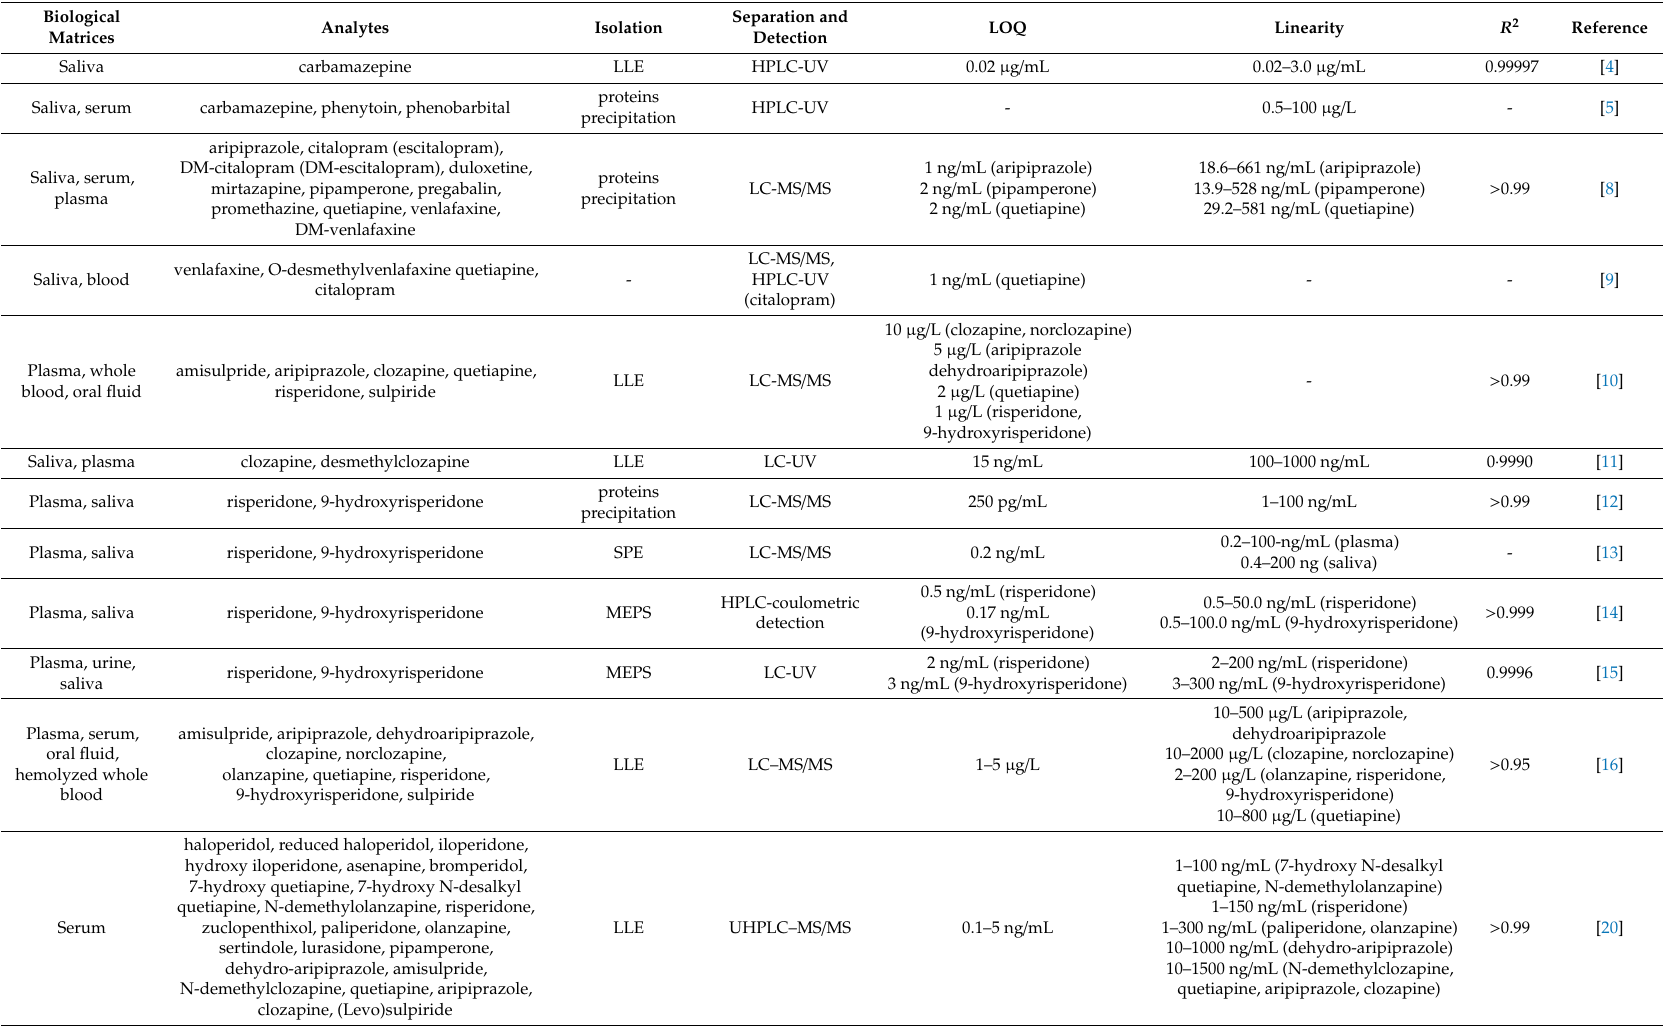
Table 3. A summary of current literature on neuroleptic analysis in saliva and other biological